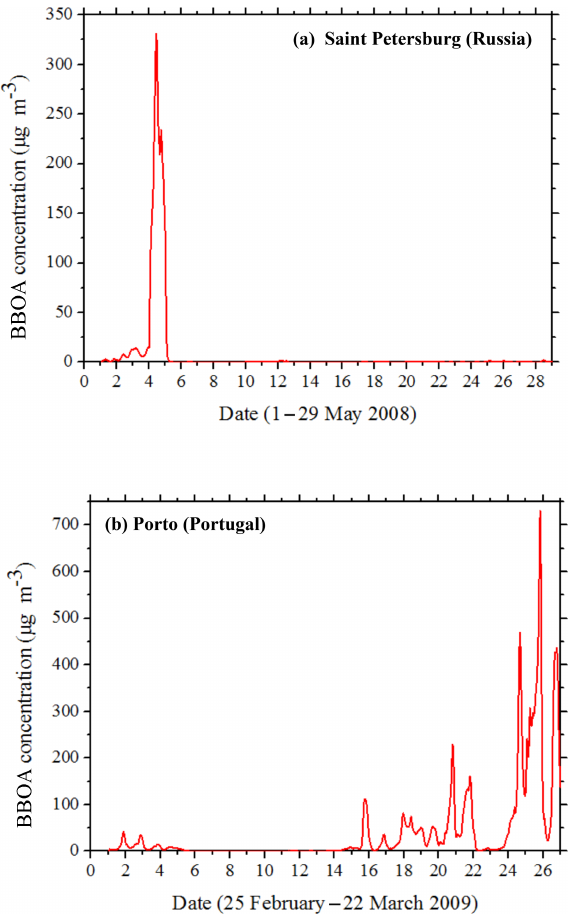
Figure 5. Time series of PM 2 . 5 BBOA concentrations in (a) Saint Petersburg, Russia, during 1–29 May 2008 and in (b) Porto, Portu- gal, during 25 February–22 March 2009.